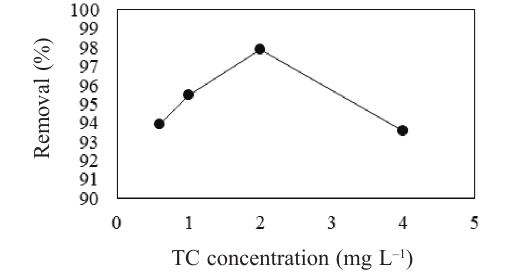
Fig. 7 – Effect of initial concentration on removal efficiency of TC onto